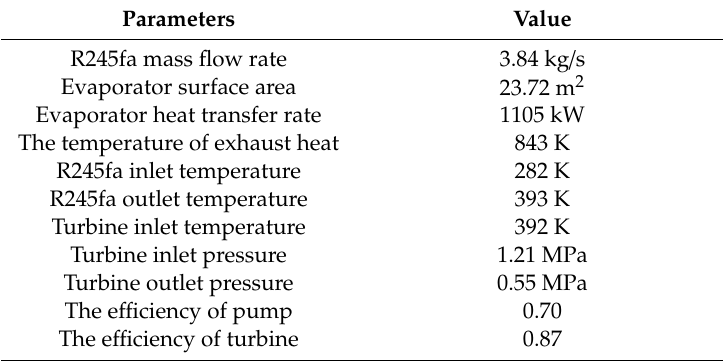
Table 4. ORC system parameters when connected a turbofan engine